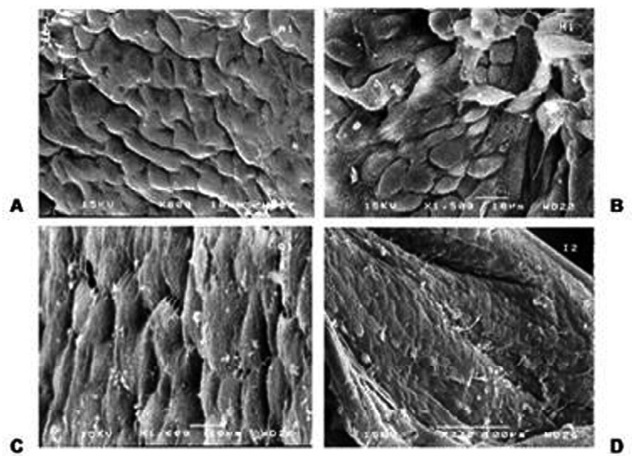
Fig. 3 - Microscopia Eletrônica de Varredura. A e B) Grupo L- Hydro: células poliédricas, de revestimento, endoteliais, semelhantes a paralelepípedo. C e D) Grupo Homoenxerto a fresco: mesmo aspecto